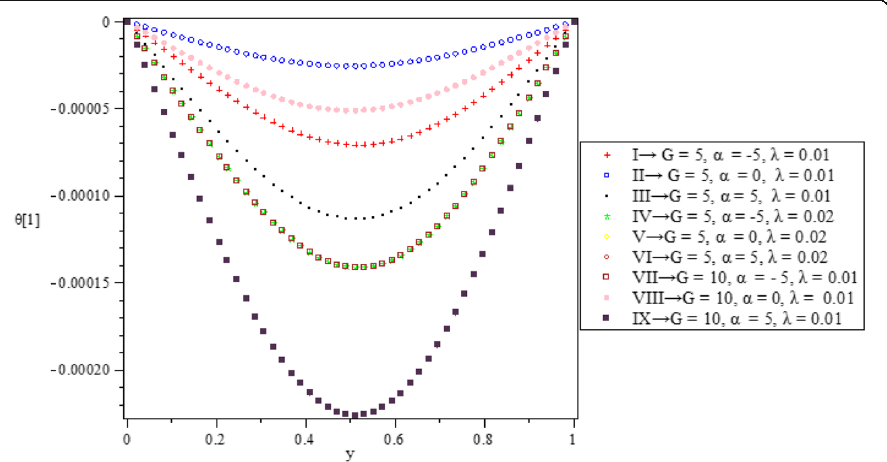
Fig. 28 First-order temperature ( θ [1] profile, r = − 1, ϵ = 0.25, P = 0.71, and β =